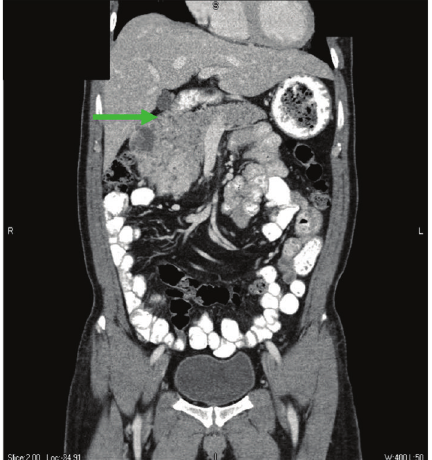
Figure 1: Displacement of duodenum by right kidney mass. Arrow indicates duodenum.